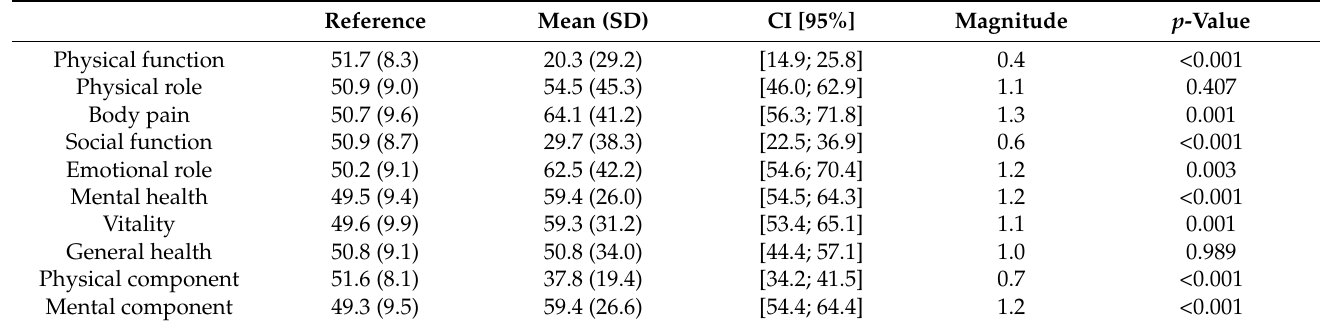
Table 2. Differences in dimensions and components of SF-12 of women with deep endometriosis treated by surgery with respect to a norm of Catalan